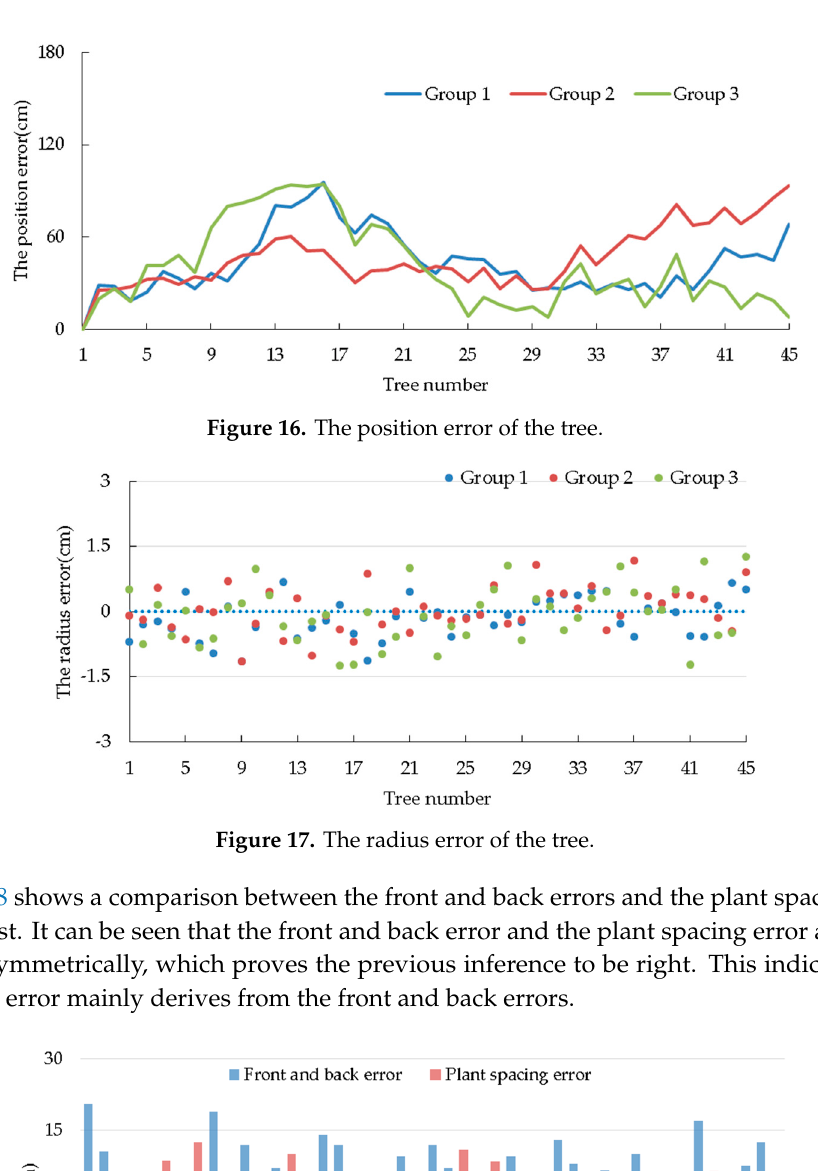
Figure 18. Comparisons of the front and back error and the plant spacing error.